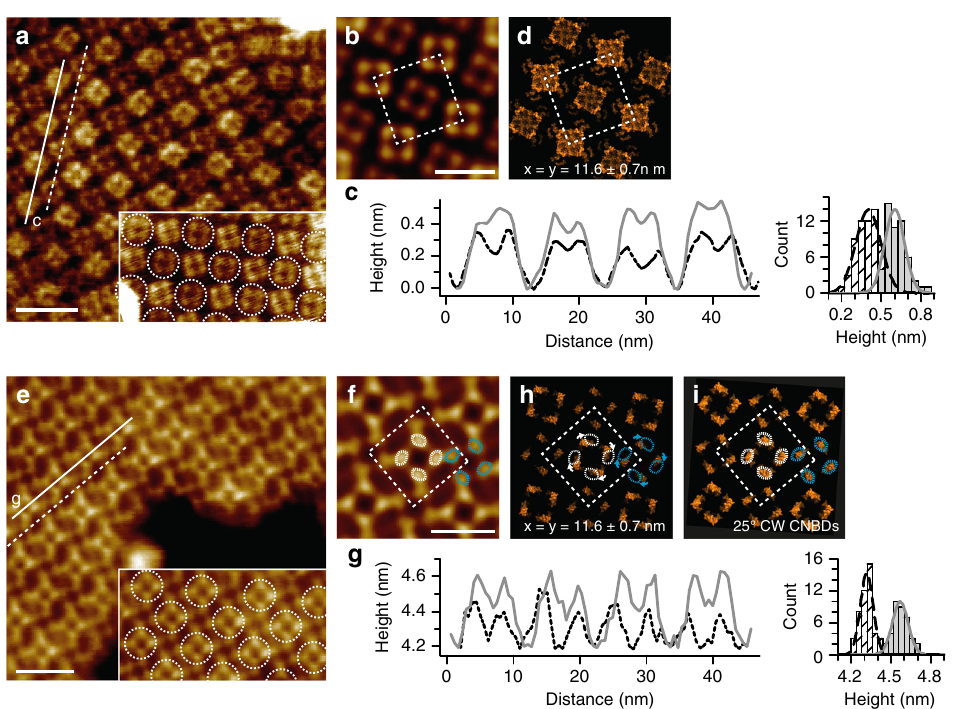
Fig. 2 Characterization of the SthK 2D-crystals in presence of cAMP. a HS-AFM image of a 2D-crystal viewed from the extracellular side. Each channel appears as a square-shaped tetramer. Each protruding turret of the pore domain within the channel tetramer is clearly resolved. Inset: The alternating packing of the channels is highlighted with dashed outlines (scale bar: 15 nm). b Four-fold symmetrized correlation average of a . The unit cell (dashed square, dimensions a = b = 11.6 nm, γ = 90°) comprises two tetramers (scale bar: 10 nm). c Left: Height pro fi les of SthK molecules along the dashed and solid lines in a are shown by the black and grey traces, respectively. Right: Height histogram of the two classes of molecules with 0.3 and 0.6 nm average protrusion heights. d Packing model of the 2D-crystal (PDB 6CJQ). e , f , g , h same as a , b , c , and d , but the 2D-crystal is imaged from the intracellular side exposing the CNBDs. Dashed circles in a and e highlight the alternating packing of the tetramers in the 2D-crystal. The stronger-protruding CNBDs on the intracellular side ( e , f ) are the less protruding ones from the extracellular side ( a , b ). White arrows in h indicate the CW rotation that the CNBDs should undergo upon cAMP-binding to match the HS-AFM data. The dotted white and cyan circles in h show the position of the protrusions in the data, which do not match the packing of the resting state SthK model. i Structural model with 25° CW rotated CNBDs matches the experimental data (compare with h ). The white and cyan dashed circles in f highlight the two neighboring tetramers of high and low height, respectively. The 25° CW rotation of the CNBDs in the model brings the model CNBD back into the white and cyan dashed circles ( i